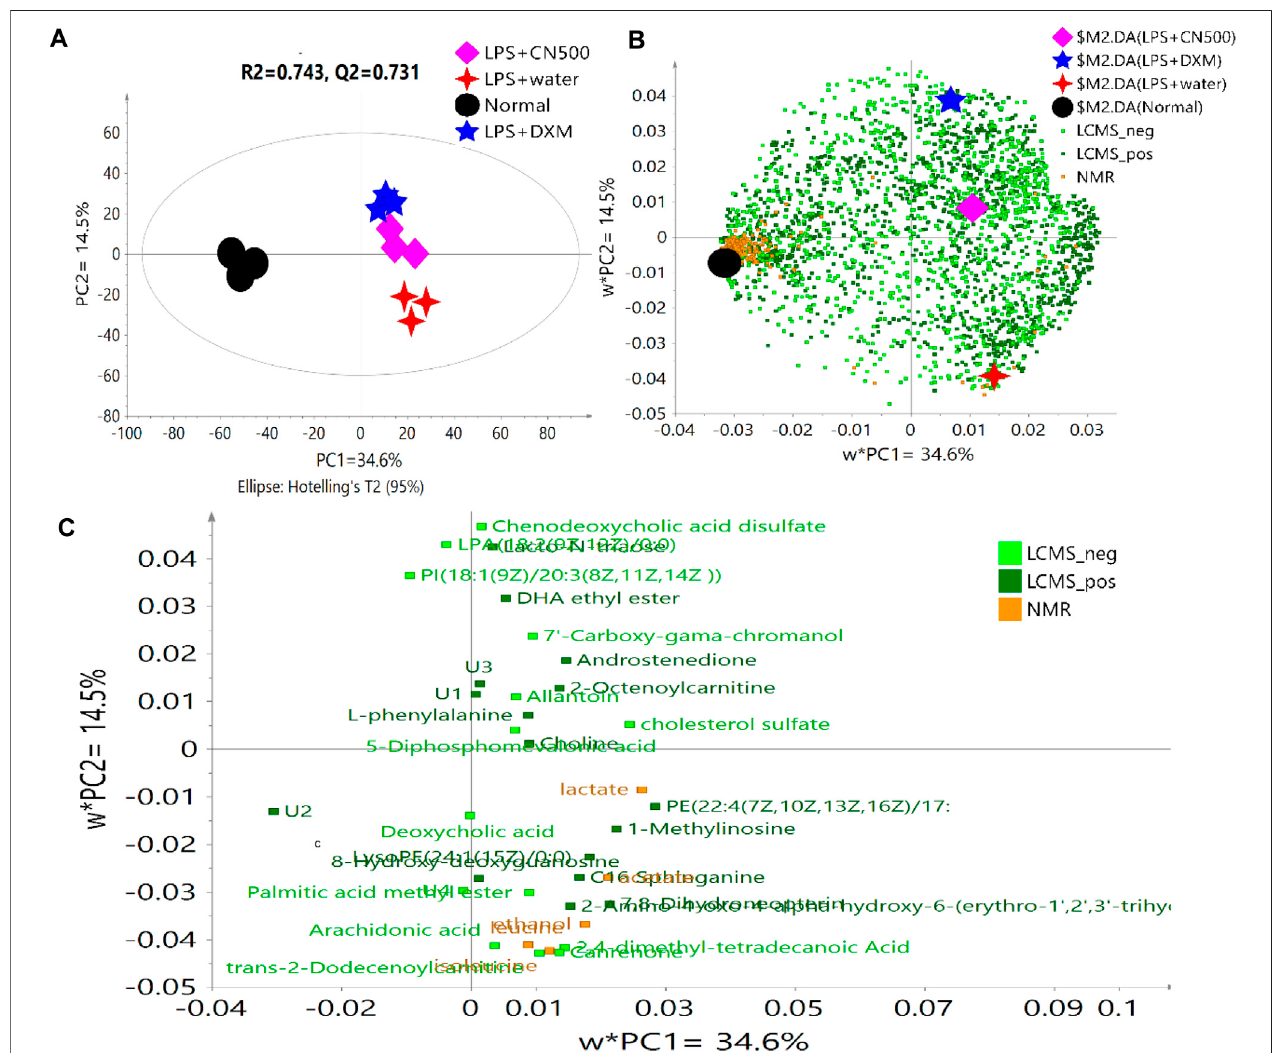
FIGURE1|(A) PLS-DAscoreplotoffourselectedgroups, (B) theoverallloadingscatterplot,and (C) loadingscatterplotoftheselectedvariablesaccordingtoVIP value > 1.3 of the two analytical methods. U (cid:2)